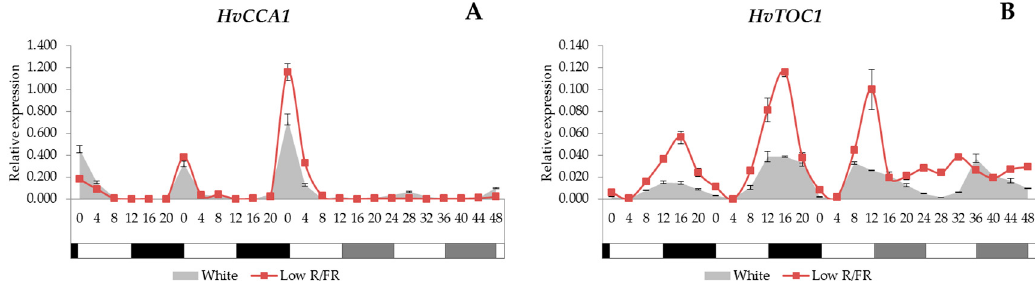
Figure 1. The expression patterns of the HvCCA1 and HvTOC1 ( A , B ) with white light and low R/FR illumination. In the first two days, the plants were illuminated for 12 h, whereas, in the next two days, they were kept under constant light conditions. Samples were collected every 4 h during four days. Transcript levels were calculated with the ∆ C t method. The values on the X-axes show the time in hours after dawn. The white and black bars symbolise the light and dark periods, while grey bars indicate subjective night. The data and error bars, which represent the standard deviation, originated from three technical replicates.